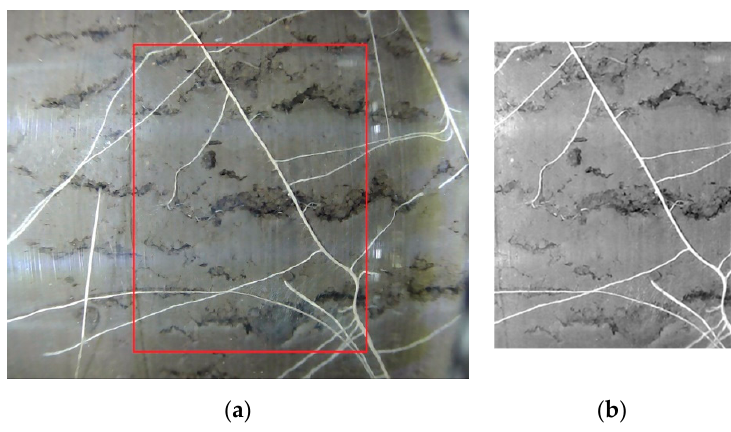
Figure 8. Division of image in HSV plane: ( a ) H Plane, ( b ) S Plane, and ( c ) V Plane.